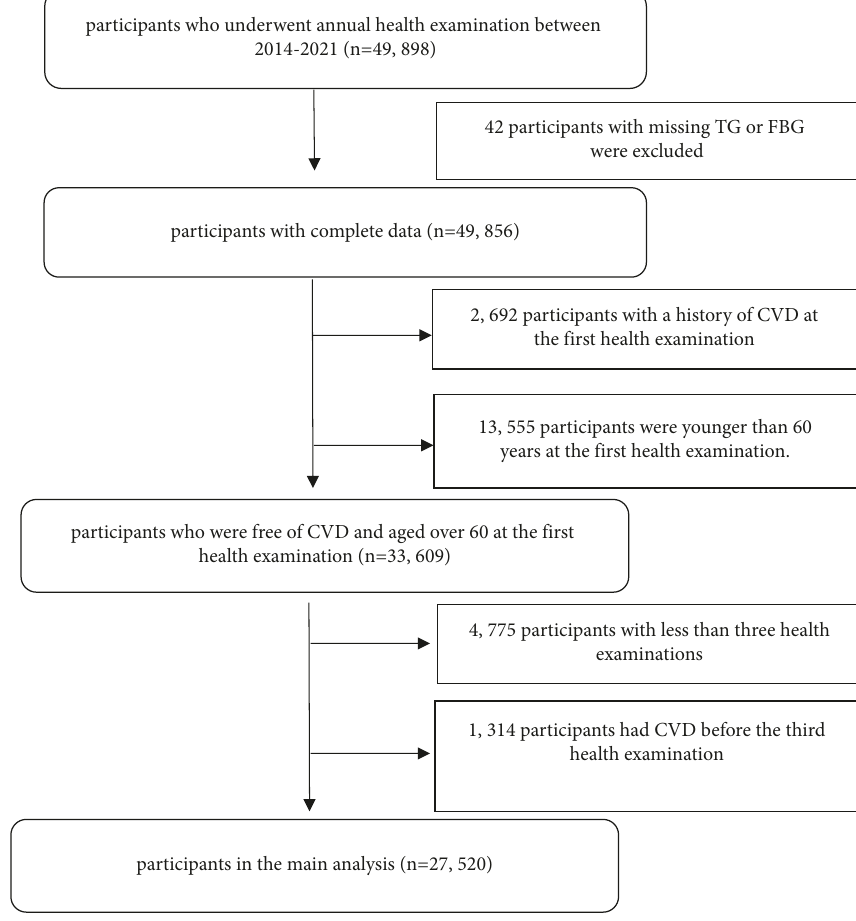
Figure 1: Flow chart of the study